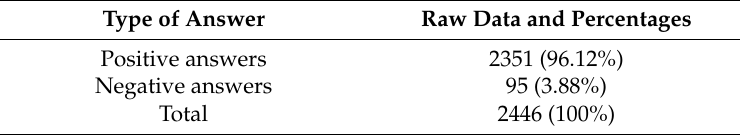
Distribution of the answers given by male and female students combined, in raw data (and % between brackets). NB: due to 18 non-answers, the total global is below 2464 (176 participants × 14